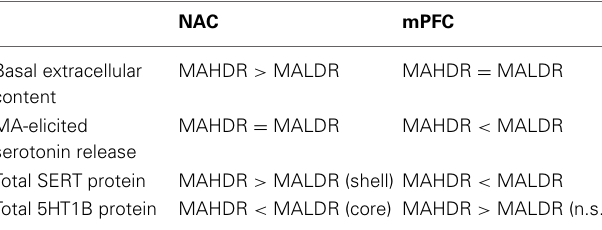
Table 5 | Comparison of the protein expression of serotonin-related proteins within the nucleus accumbens (NAC) and medial prefrontal cortex (mPFC) of the MAHDR and MALDR selected